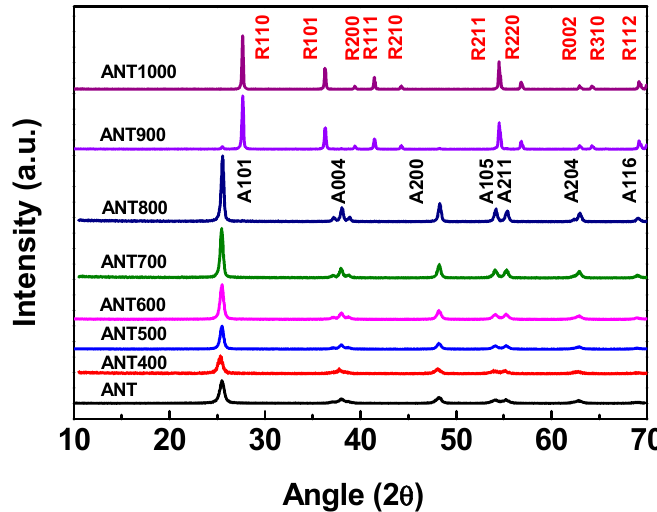
Figure 3. X-ray diffraction peaks of anatase TNPs annealed at different temperatures. The R and A represent the rutile and anatase phase, respectively, where the number followed by the R or A represents the crystal plane.